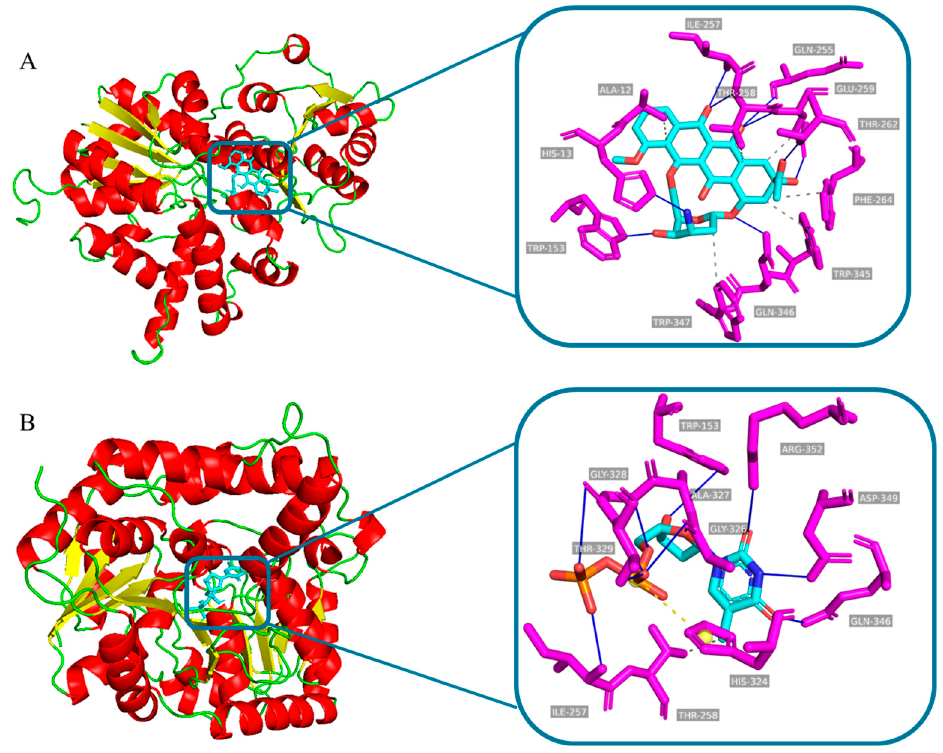
Figure 8. Molecular docking of DNR and TDP with our DnmS model. ( A ) DNR docking in the binding site of DnmS. ( B ) TDP docking in the binding site of DnmS. Images were made using PyMOL software.